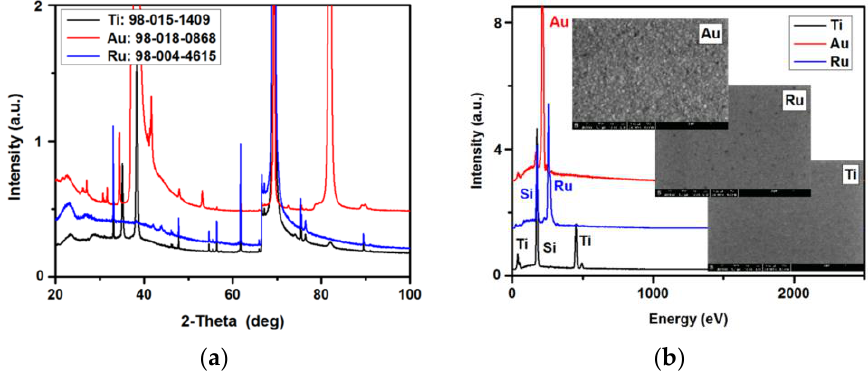
Figure 3. ( a ) XRD pattern of deposited metals, ( b ) EDS spectra of deposited metals with SEM images of the representative metals’ surfaces.